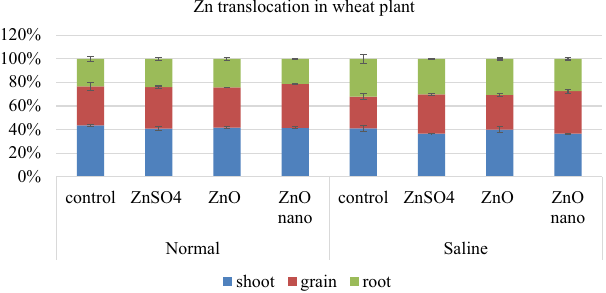
Figure 4. Percentage distribution of Zn translocated in different plant parts of wheat at maturity (Each value is a mean, n = 3 statistically significant at p ≤ 0.05, T bars represent ± standard error of means).